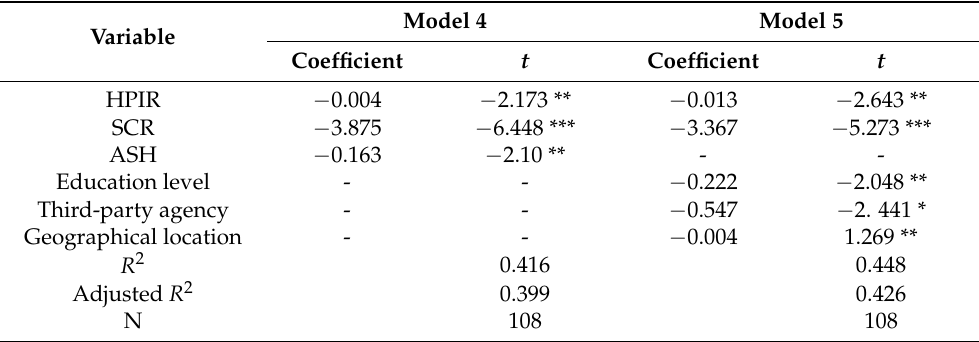
Table 6. The impacts of various factors on actors’ supportive perception in